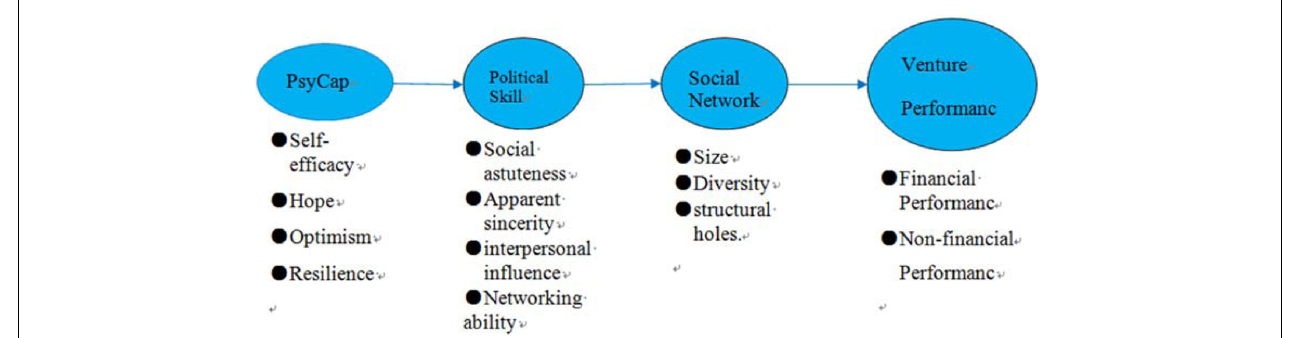
FIGURE 1 | Conceptual